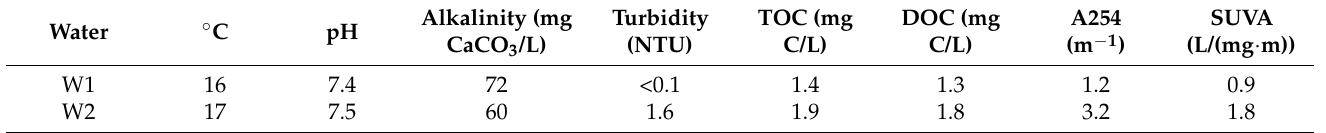
Table 2. Water characteristics fed to PAC/coagulation/MF pilot during